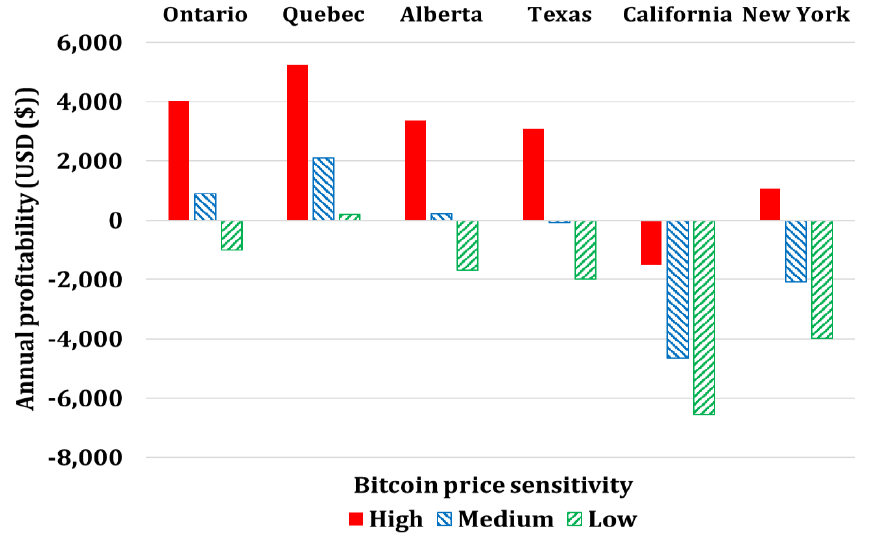
Figure 19. Annual profitability results of operating an individual Antminer S17e in six North Amer- ican locations measured in USD.